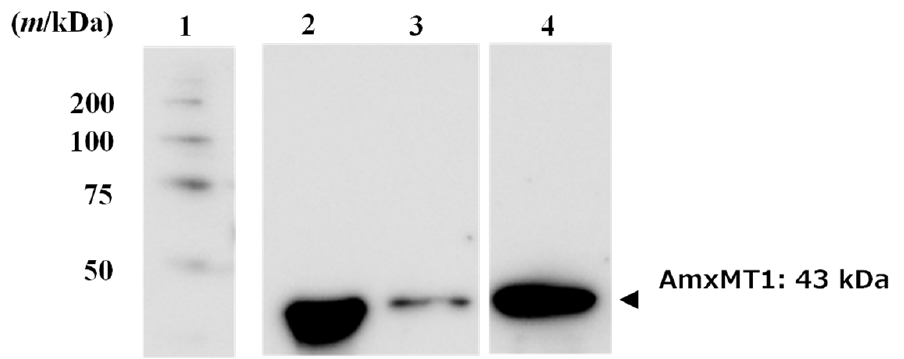
Figure 5. AmxACP3 pull-down assay to show the interaction between AmxACP3 and AmxMT1. AmxMT1 was detected by Western blotting with anti-His tag mouse IgG and HRP-linked anti-mouse goat IgG. Lane 1: Protein molecular weight marker. Lane 2: Supernatant of cell-free extract of E. coli that produced AmxMT1. Lane 3: Eluate from AmxACP3 free-Sepharose TM resin. Lane 4: Eluate from AmxACP3-immobilized Sepharose TM resin in a pull-down assay.